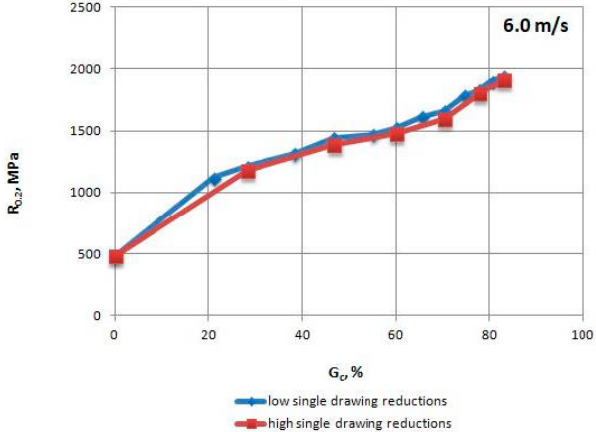
Figure 6. Change of the proof yield strength R 0.2 of TRIP steel wires for variants with low and high single drawing reductions, at a speed of 6.0 m/s, as the total drawing reduction function.